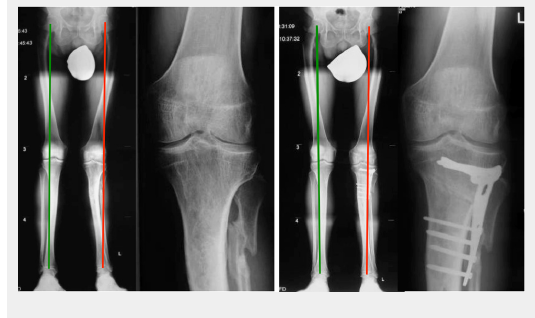
Multi-level surgery: 53 year old patients with rheumatoid and psoriasis arthritis, consistent of two total hip arthroplasties, two total knee arthroplasties, realignment surgery of the right ankle, and two total ankle